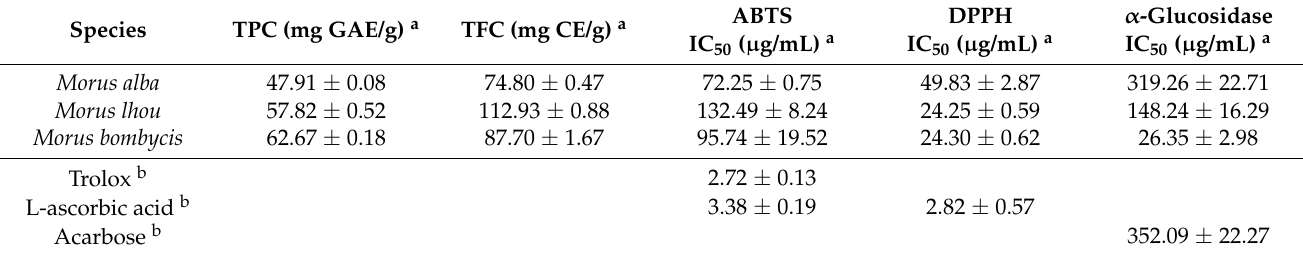
Table 1. Comprehensive comparison of the MeOH extracts of the leaves of three dominant Morus species on TPC/TFC analysis and DPPH/ABTS radical scavenging and α -glucosidase inhibitory ac-